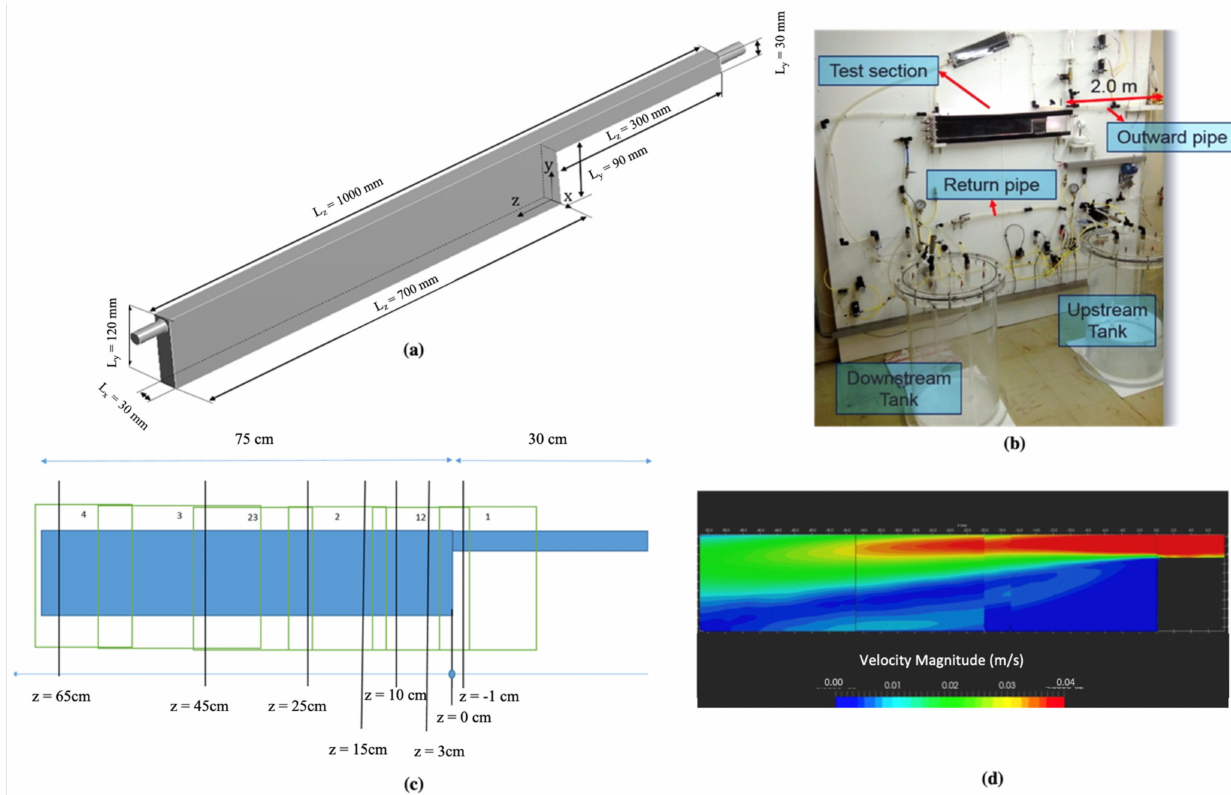
Figure 7. Development of a large-aspect-ratio backward-facing step. ( a ) Dimensions of the sec- tion; ( b ) Experimental setup; ( c ) Sliding windows used in the PIV measurements and vertical lines over which streamwise velocity profiles are extracted; ( d ) example of postprocessed PIV velocity magnitude for Re =